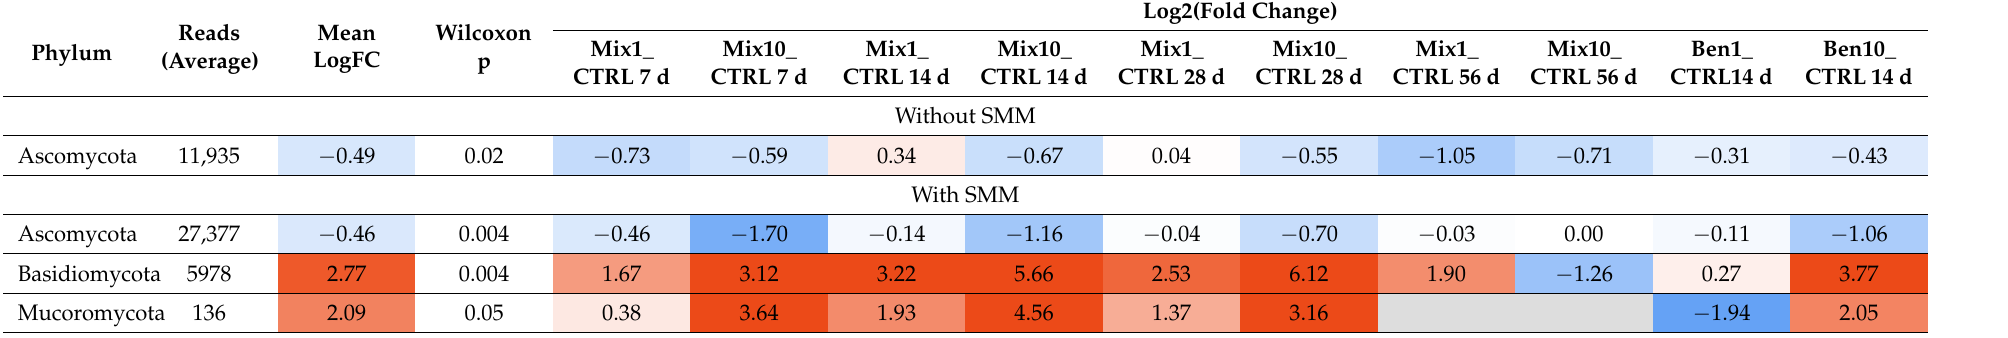
Table 9. Paired comparison of abundances of various fungal phyla between control and treated soil samples.